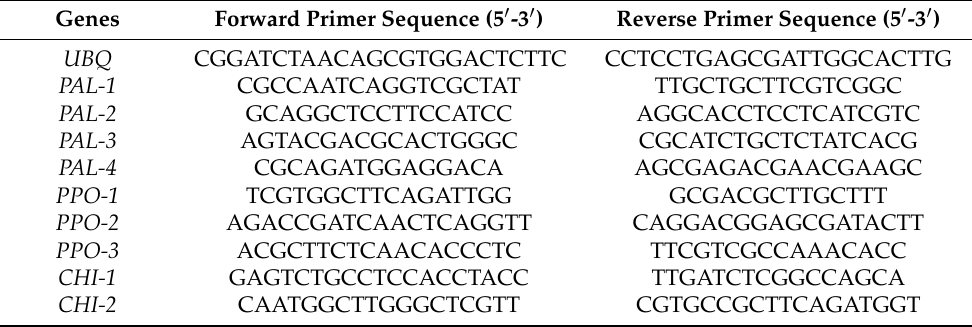
Table 1. The primers for qRT-PCR analysis in this study. Genes Forward Primer Sequence (5 (cid:48) -3 (cid:48) ) Reverse Primer Sequence (5 (cid:48) -3 (cid:48)